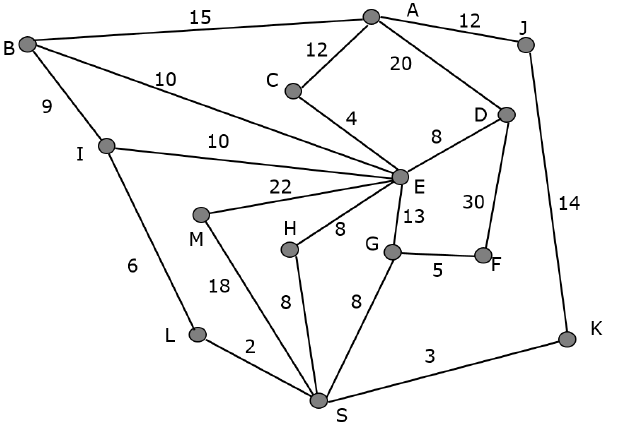
Figure 2. Graphical representation of the nondirected weighted graph G whose weights denote the gasoil consumption between